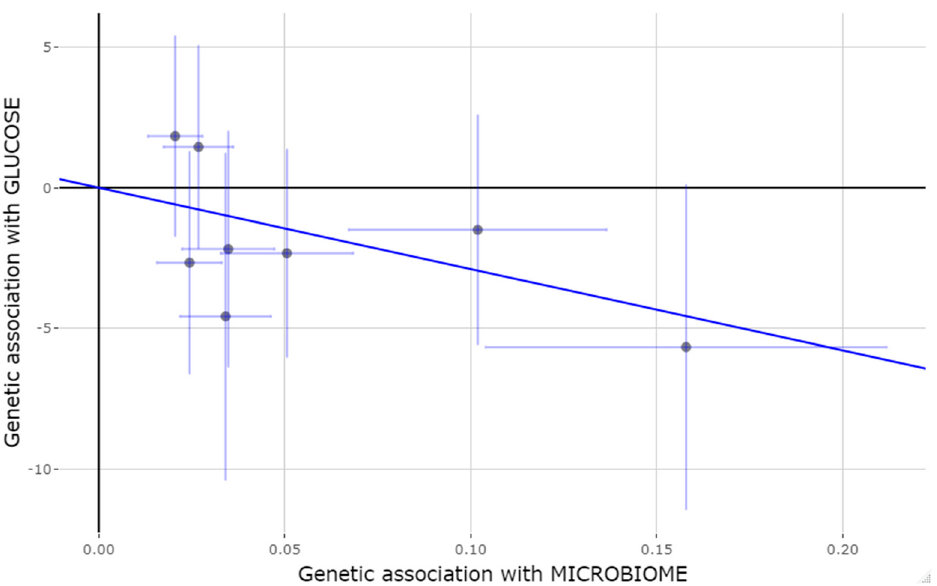
Figure 4. Mendelian randomization estimates for the association with fasting plasma glucose for the eight selected instruments. Individual SNPs and global association using the IVW method. SNPs: Single nucleotide polymorphisms.